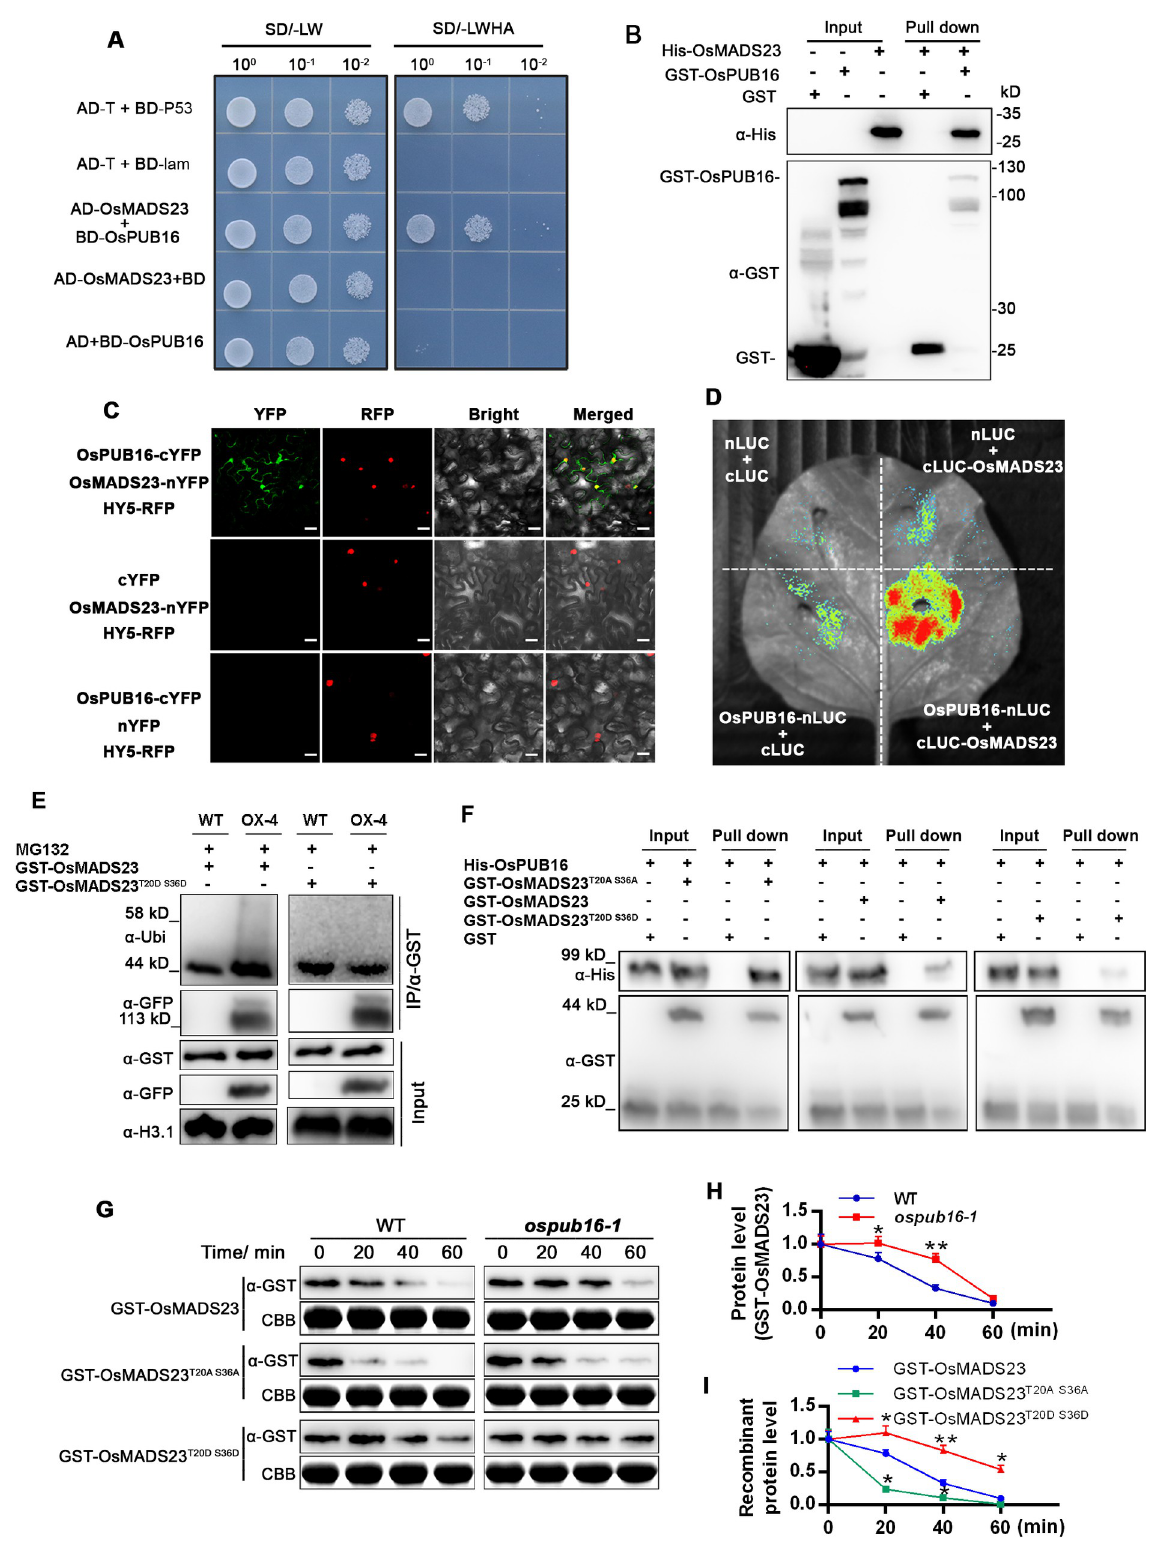
Fig 6. OsPUB16 mediates the ubiquitination and degradation of OsMADS23 via the physical interaction. (A) Yeast two-hybrid assays showing the interaction between OsPUB16 and OsMADS23. Yeast cells were grown on synthetic defined (SD)/-Leu-Trp (-LW) medium